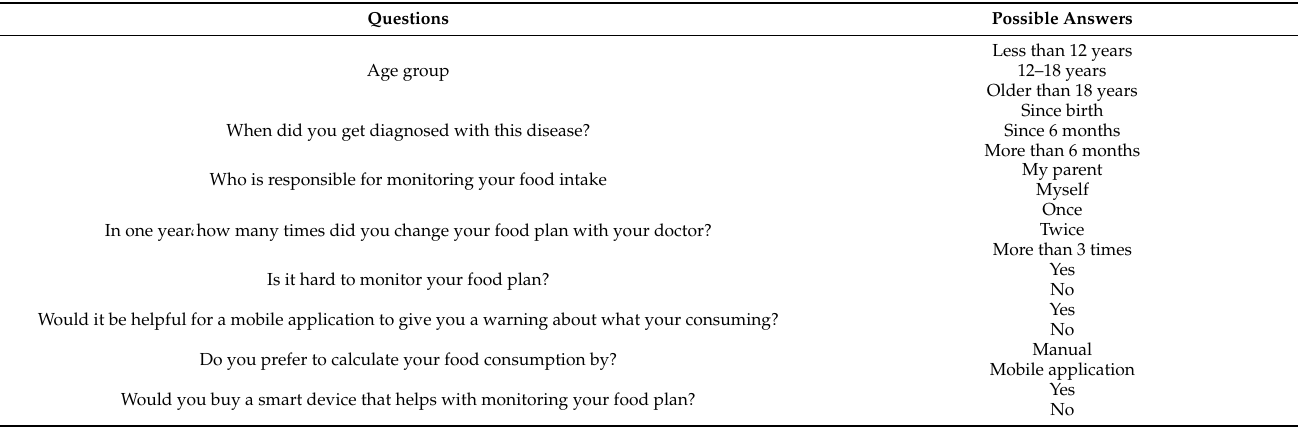
Table 2. The questions and possible answers that were used in the questionnaire.